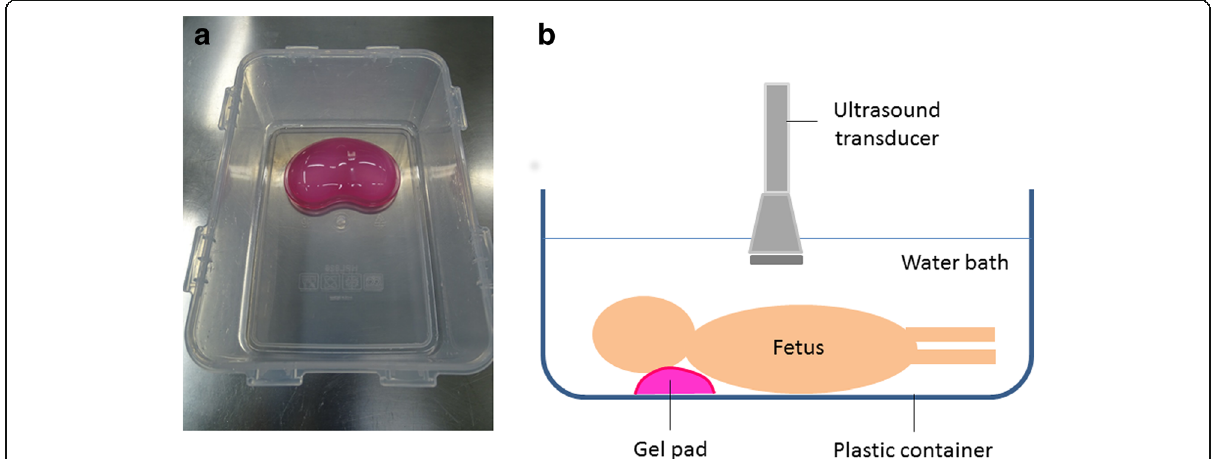
Fig. 1 Photograph of an empty 2 L plastic rectangular container ( a ) with a pink silicon gel pad for postmortem ultrasound water bath. Diagram demonstrating the set-up of the water bath ( b ). The container is filled with water, left to rest for 15 min and then the foetus placed in the bath with neck supported by gel pad. The ultrasound transducer is partly submerged in the water